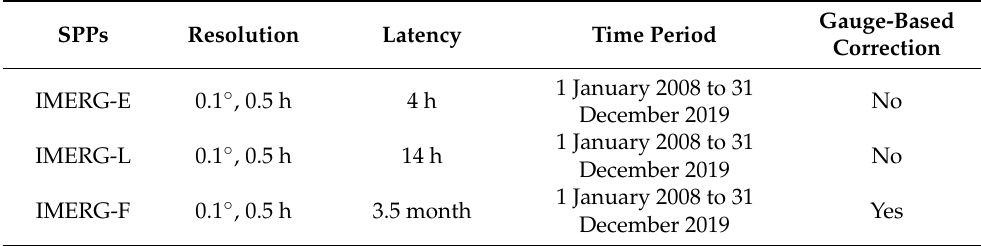
Table 1. Brief information of the IMERG SPPs used in this